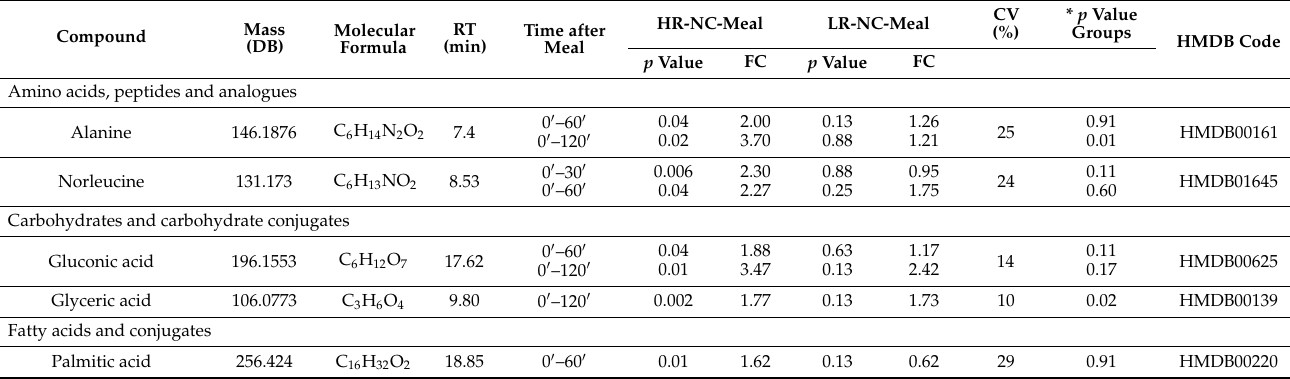
Table 3. The percentage differences in postprandial plasma metabolite levels after NC-meal intake in the PROX1 low- (LR) and high-risk (HR) genotype men. Metabolites that showed statistical significance after Wilcoxon signed-rank test. Mass found in the Human Metabolome Database (HMDB) (http://www.hmdb.ca/accessed, on 20 April 2021); RT, retention time expressed in minutes; p value; * p value for between-groups comparison (Mann–Whitney U test); CV, coefficient of variation of the metabolites in the QC samples; FC, fold change in the comparison. Ten individuals from the HR group participated in NC-meal (six common with